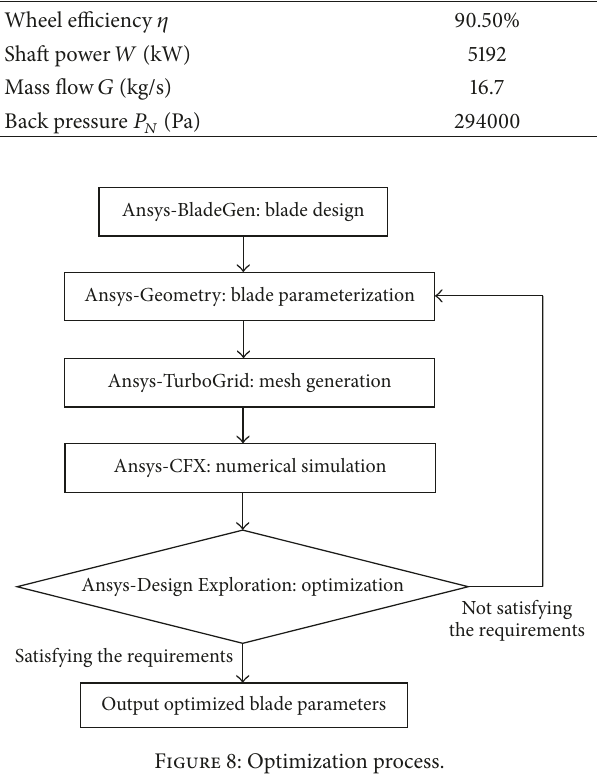
Figure 7: Optimization strategy. Table 7: The contrast of design value and CFD value of the overall performance of the centrifugal turbine. Variable